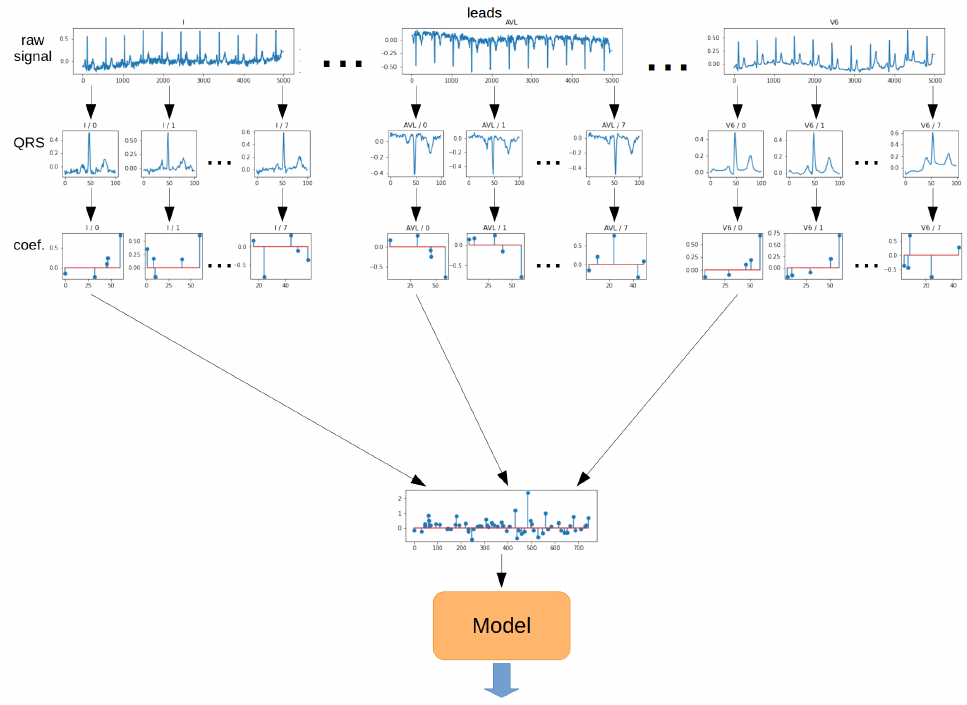
Figure 12. Aggregation method—Single.